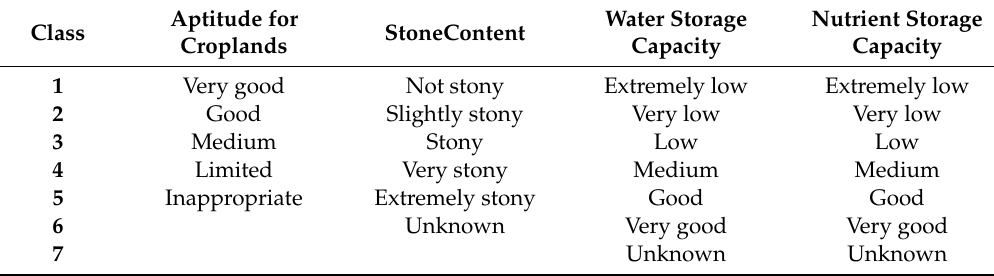
Table 2. Classes selected of the soil suitability map divided in levels.